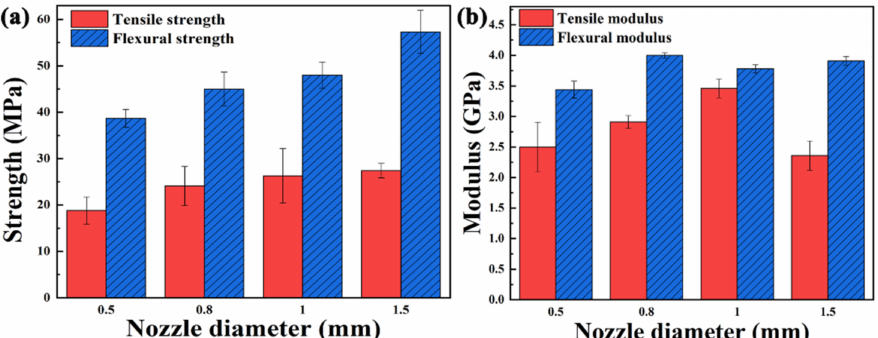
Figure 7. ( a ) Mechanical strength and ( b ) modulus of samples printed by various nozzle